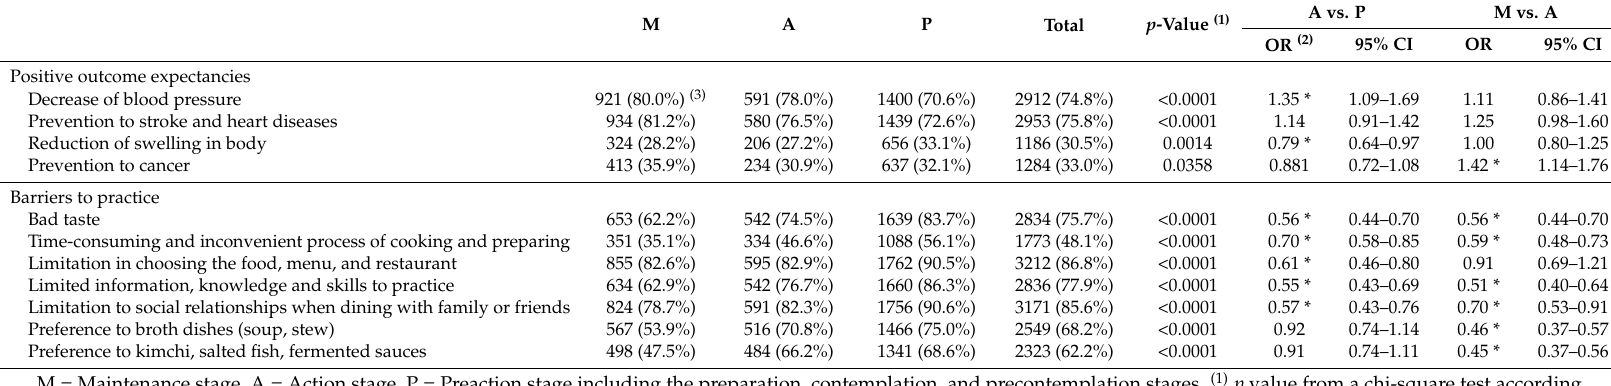
Table 3. Cognition of positive outcome expectancies and barriers to practicing according to the stages of